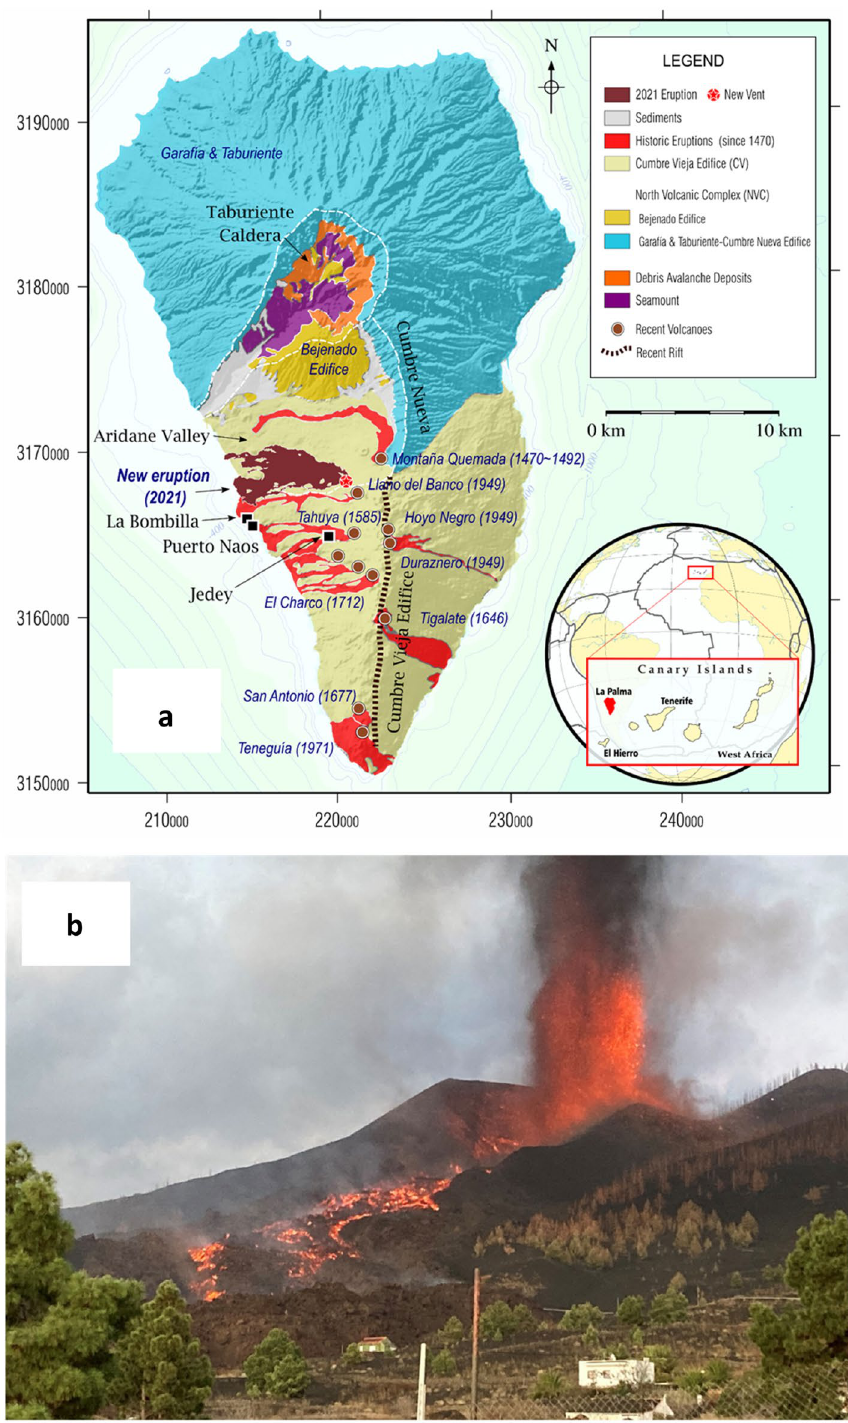
Figure 1. Geographic location and geologic elements of La Palma and eruption photo. ( a ) Location of Canary Islands and La Palma Island (lower inset) and simplified updated geological map (UTM28 North reference system, coordinates in m). The main volcanic complexes, ridges as well as the last historical eruptions on the Island are shown. The towns of Jedey, La Bombilla and Puerto Naos (black squares) are also depicted. The 2021 lava flow field was the most voluminous of the last 600 years. See upper insets for scale and keys description. ( b ) Snapshot of the eruption during the first days after September 19, 2021. Photo by the authors (September 23, 2021; 20:12 local time). GMT software (www. gener ic- maping- tools .org) and Microsoft PowerPoint 2016 were used to create this